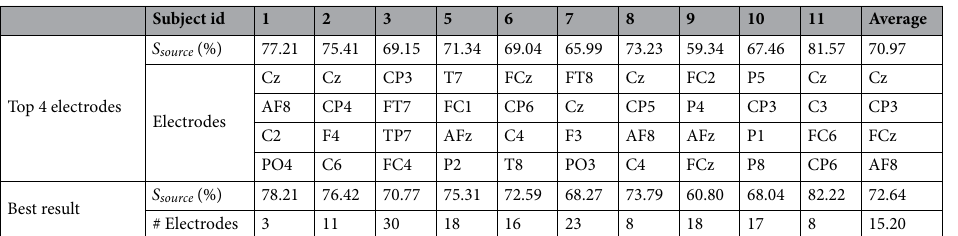
Table 3. S source on the data of the top 4 electrodes for each subject separately.